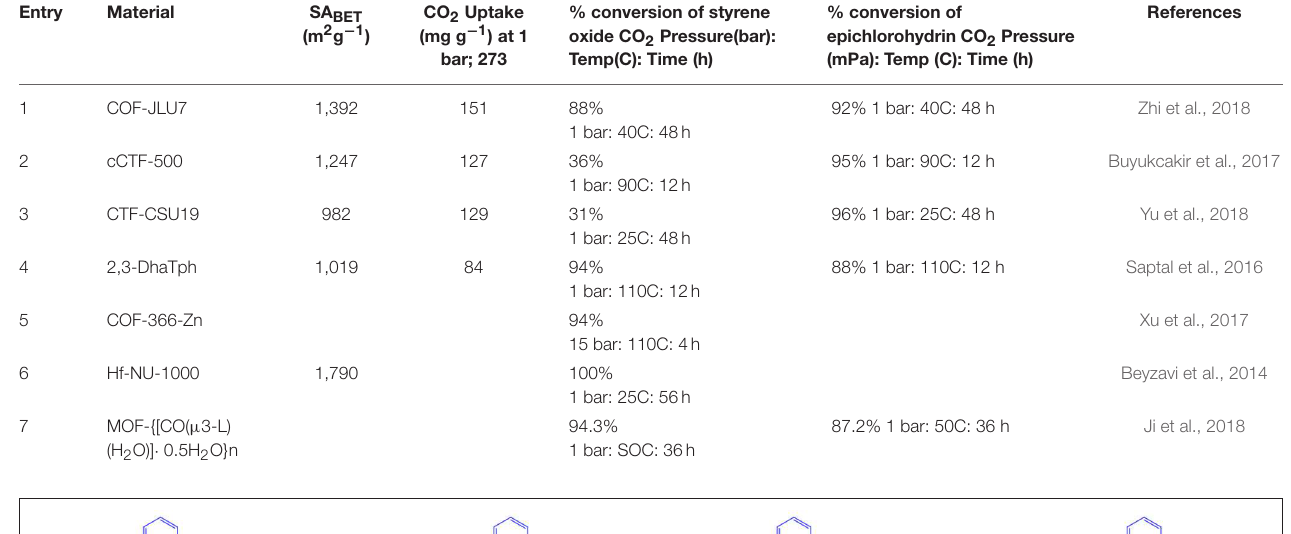
TABLE 3 | Table of COFs and selected MOFs capable of fixation of CO 2 to epoxides for the synthesis of cyclic carbonates.